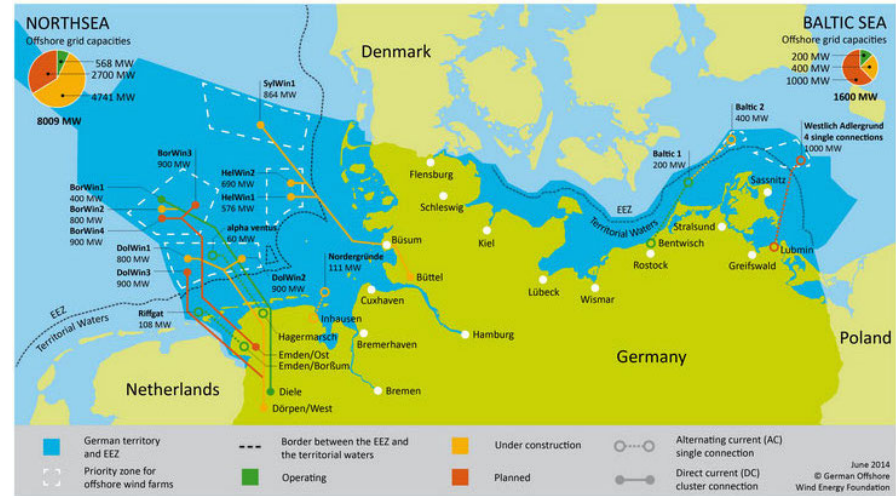
Figure 9. Planned transmission lines development in North Sea and Baltic Sea (Image: